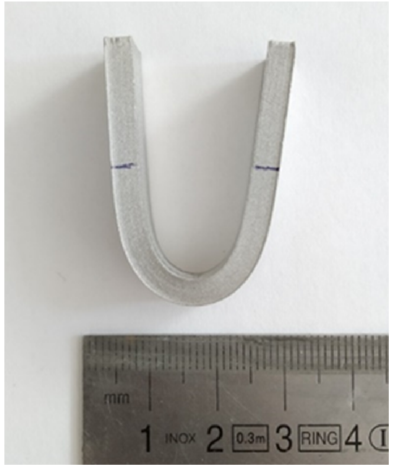
Figure 2. U-bend